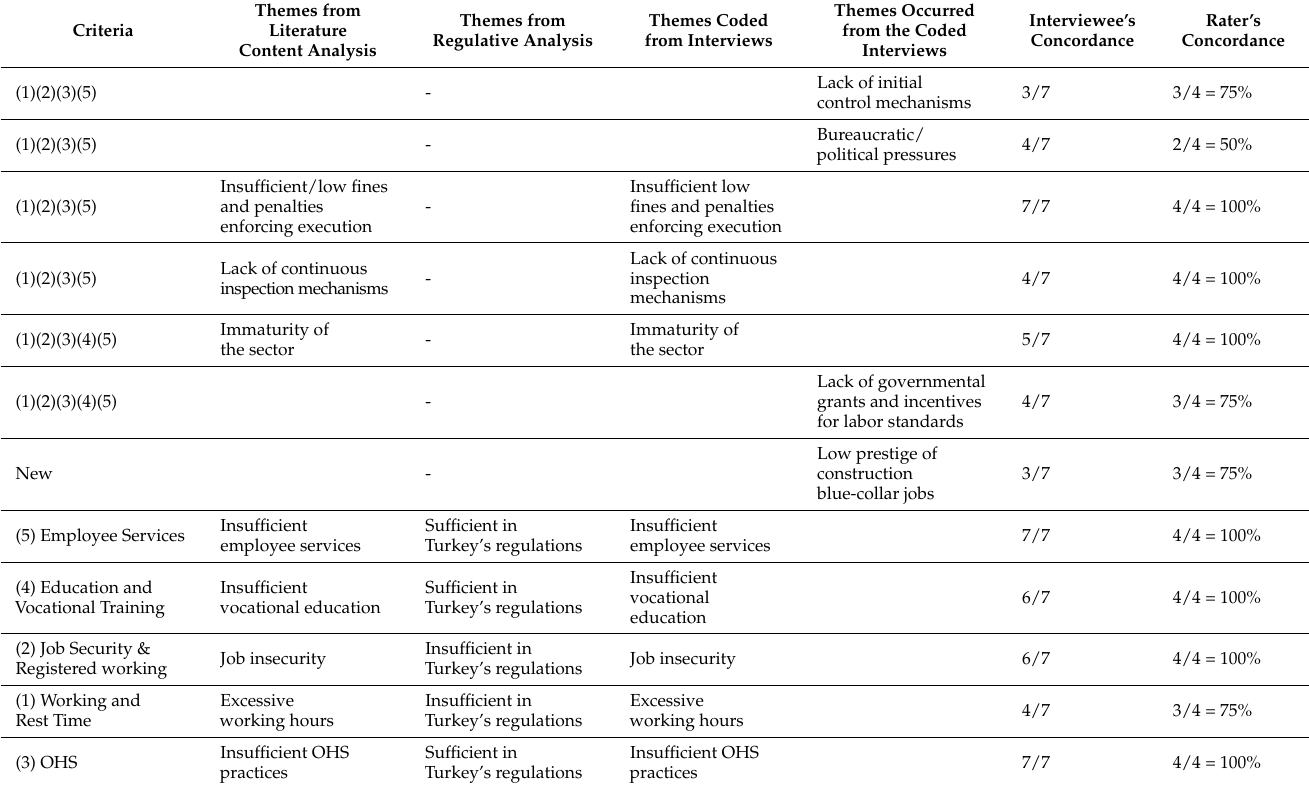
Table 3. Comparison of Findings from Literature, Regulative Analysis, and Interviews for